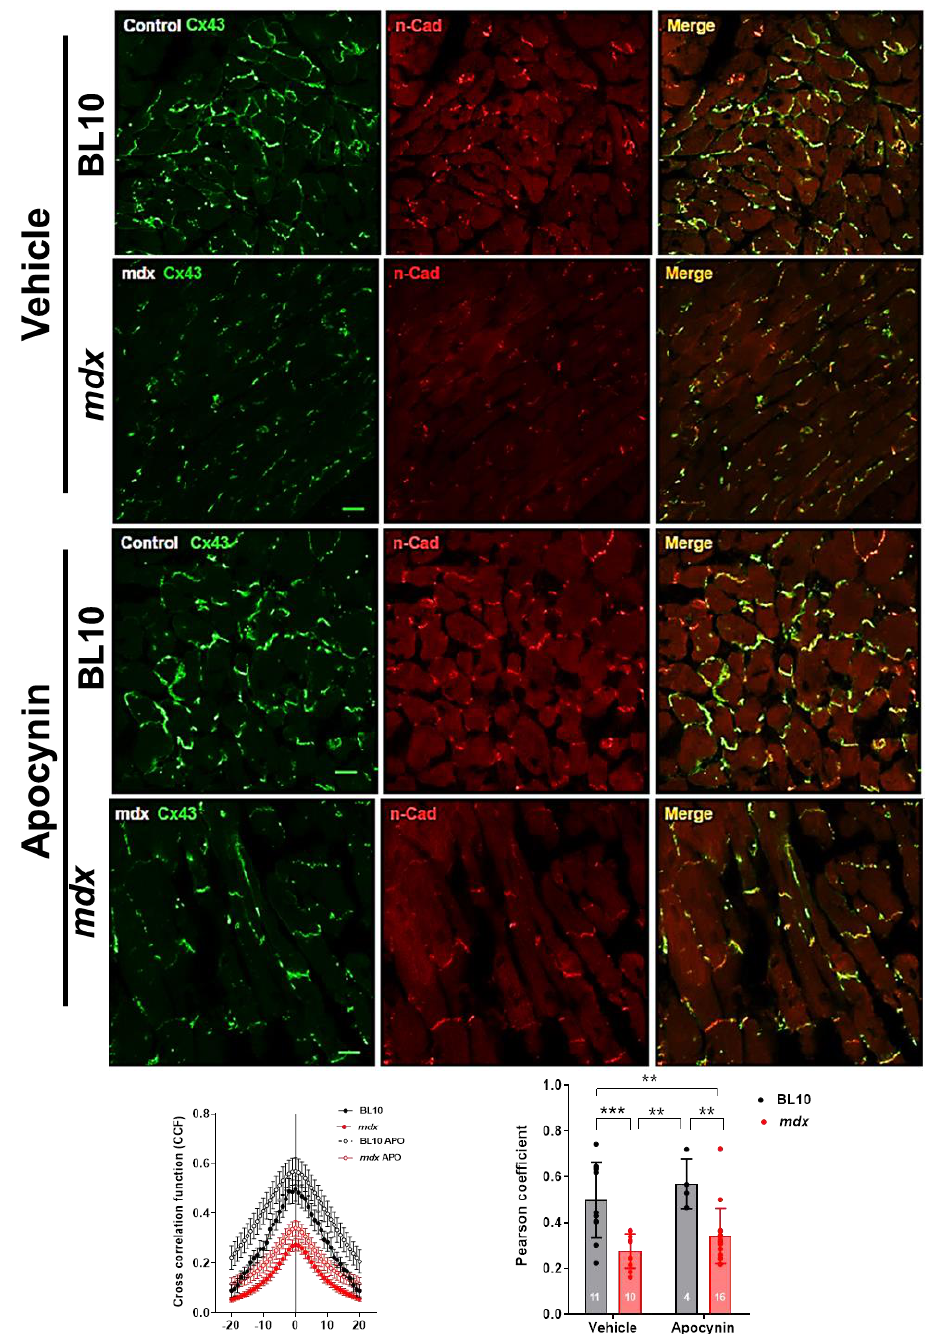
Figure 5. Reduced co-localization of Cx43 and N-cadherin in dystrophic hearts. 10-month-old mdx and their background controls (BL10) mice received the vehicle or apocynin for one month. At the end of this period, hearts were harvested and processed for confocal microscopy. The upper panels show representative immunofluorescence confocal images of cardiac sections for connexin 43 (Cx43, green), N-cadherin (N-Cad, red) and the merge of both signals (co-localization). The bar indicates 10 µ m. Below, graphs depicting the analysis of Pearson correlation coe ffi cients obtained for the co-localization of Cx43 and N-cadherin in the confocal microscopy images. ** p < 0.005, *** p < 0.001 for comparisons indicated by the brackets, ANOVA followed by Newman–Keuls post-hoc test. The n is indicated in each bar of the graphs.